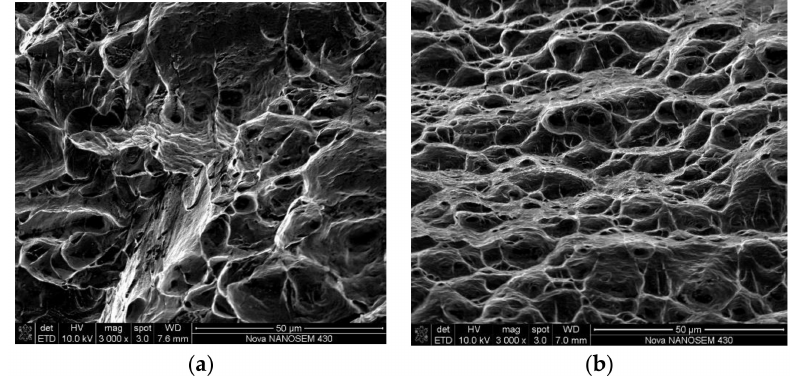
Figure 12. Photographs of fractured tensile samples: ( a ) Weld joint, ( b ) base